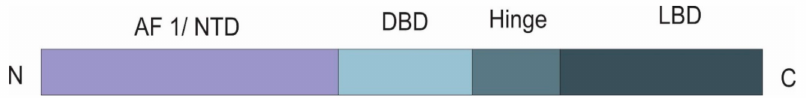
Figure 3. Schematic presentation of sequence of domains in androgen receptor. N: amino terminal, C: carboxyl end, AF 1: Activation function 1, NTD: N terminal Domain, DBD: DNA binding domain, LBD: Ligand Binding